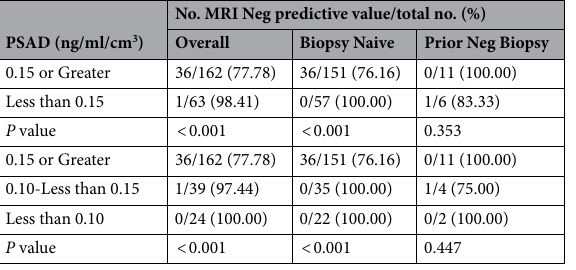
Table 3. MRI negative predictive value of CSPCa detection according to PSAD and PB history. PSAD PSA density.